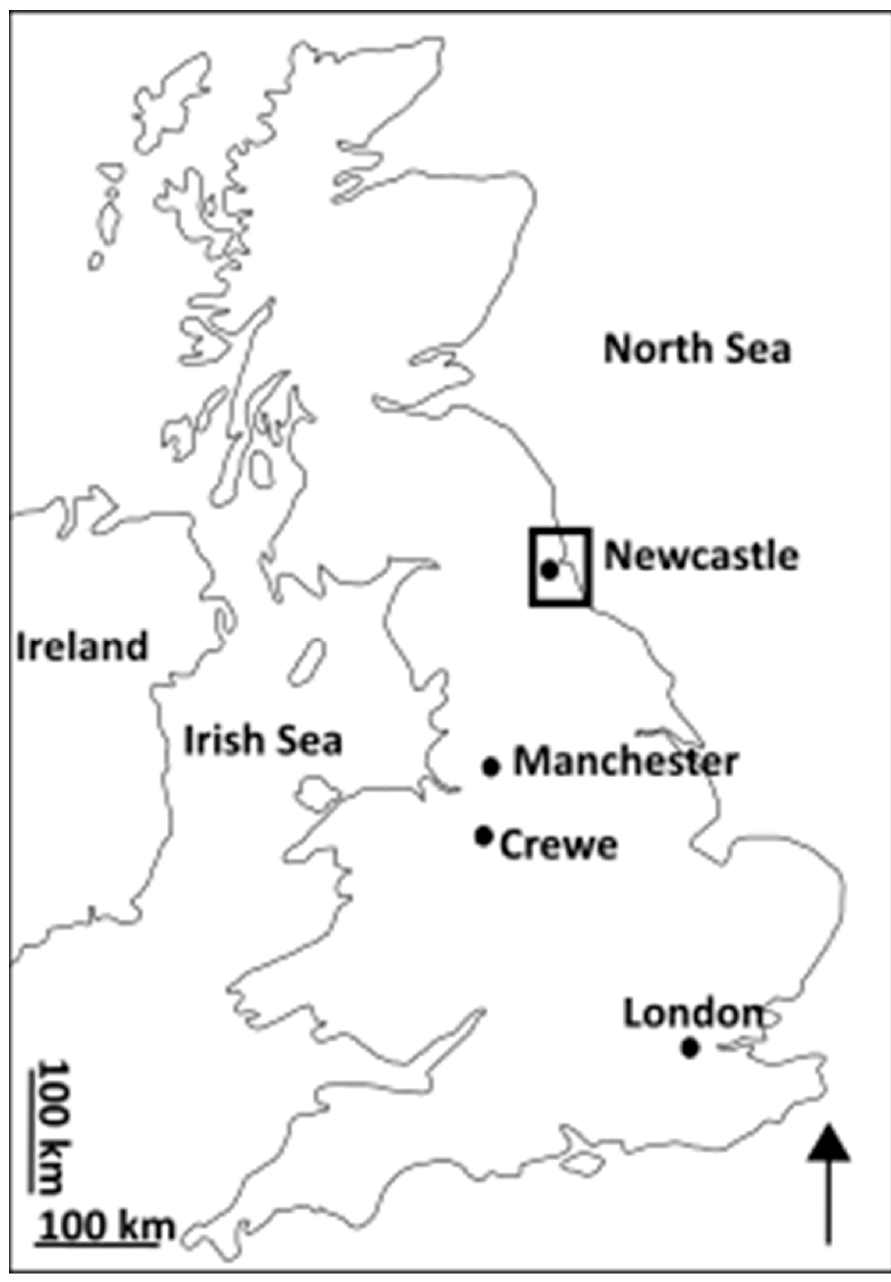
Figure 2. Map of the UK and approximate location of the study area (from [11]).